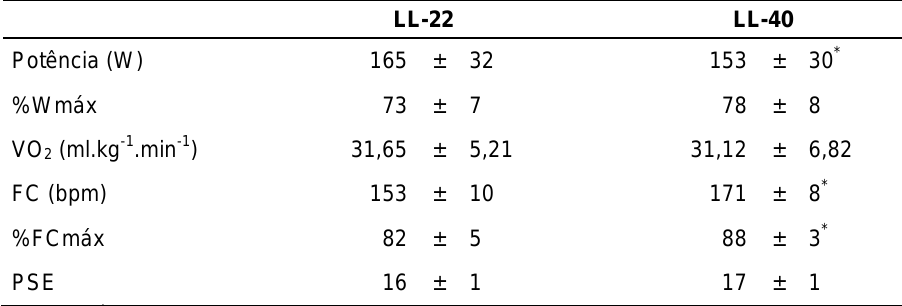
-22) e LL-40 (VO -40) 2 2